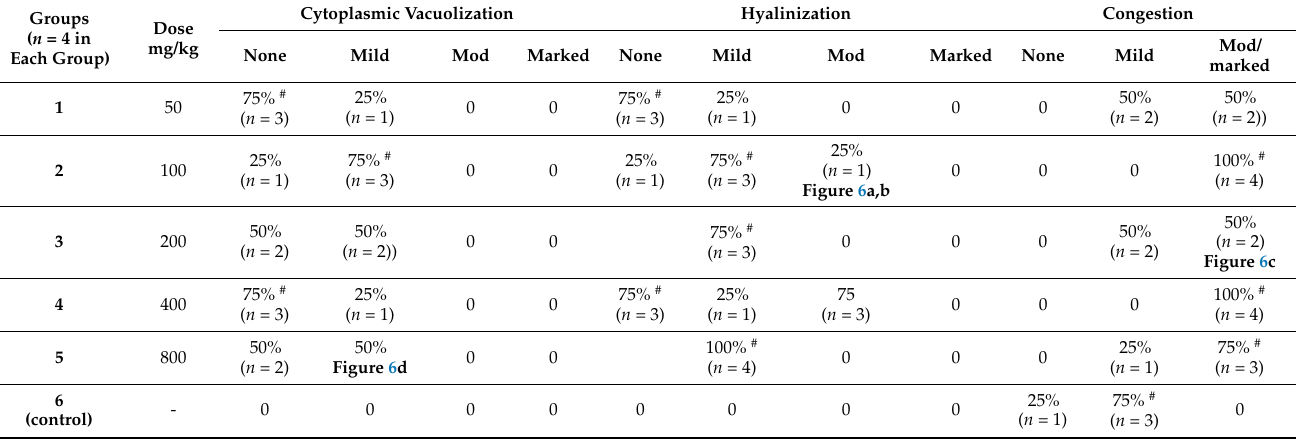
Table 7. Cardiac histological findings in acute toxicity study ( n =